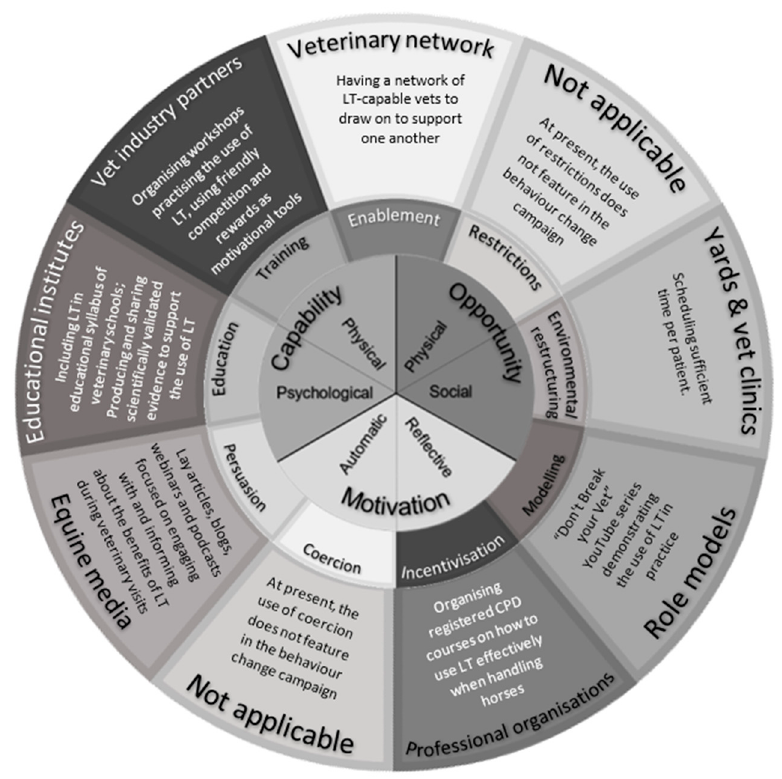
Figure 4. Overview of continued multi-intervention, multi-stakeholder behaviour change strategy to encourage the use of learning theory in equine veterinary practice. (LT = learning theory; CPD = continuing professional development).